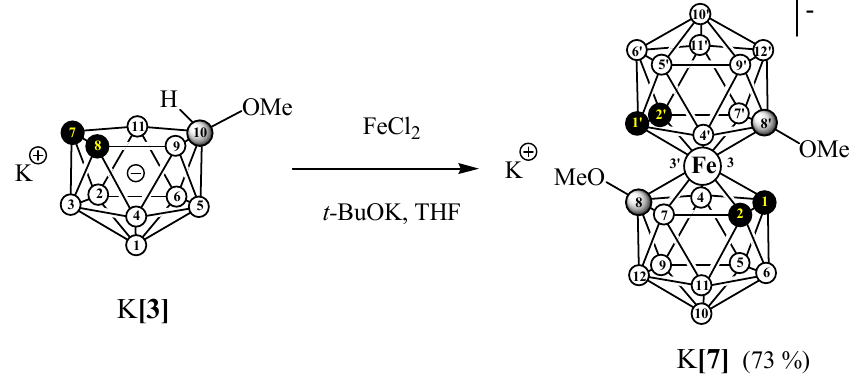
Scheme 4. Synthesis of 8,8 ′ -dimethoxy derivative of iron bis(dicarbollide).